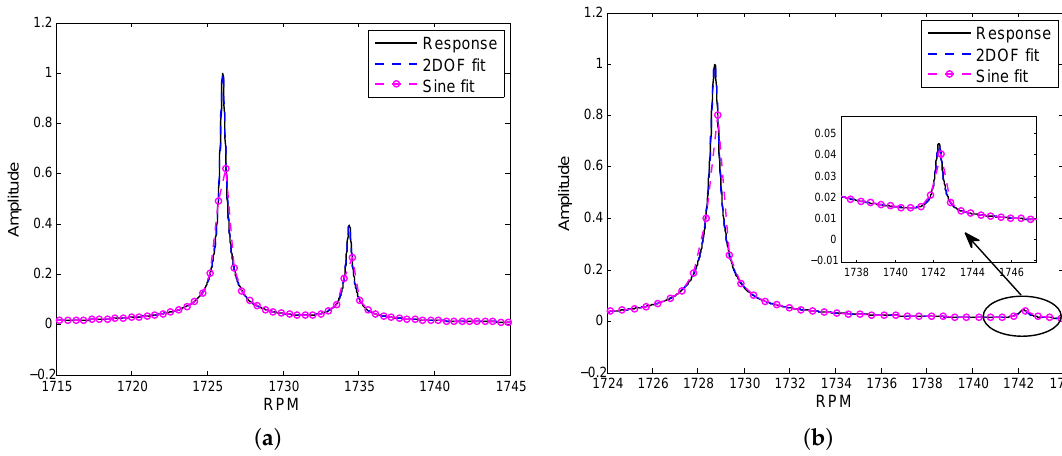
Figure 9. Comparison of non-dimensional amplitudes obtained by different fitting methods for EO = 7 and ζ 1,2 = 0.0001, ( a ) SD = 0.05, ( b ) SD = 0.10.